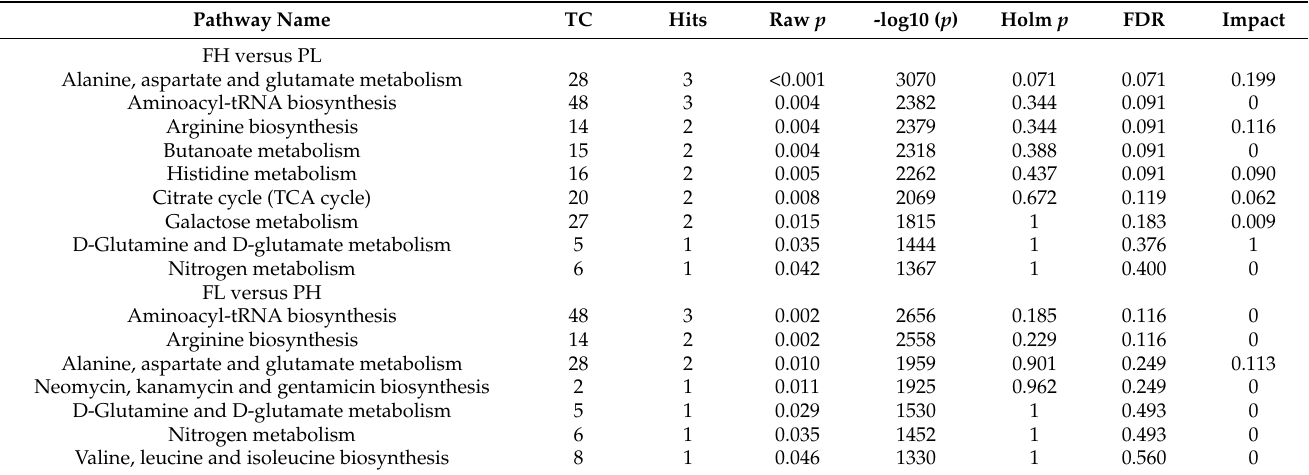
Figure 4. Metabolomics pathways of the meat extract revealed significant differences in the drawn pathway according to ( A ) FH versus PL and ( B ) FL versus PH. In the scatter plot, the x-axis indicates the impact on the pathway, whereas the y-axis indicates significant changes in the pathway by detected metabolites. Darker nodes represent higher p -values from the enrichment analysis, while larger nodes reflect greater impact from the pathway topology analysis. FH: feedlot system with high average daily gain (ADG); FL: feedlot system with low ADG; PH: pasture system with high ADG; and PL: pasture system with low ADG. Table 3. Results from polar meat extract pathway analysis from comparisons between FH and PL and FL and PH cattle.